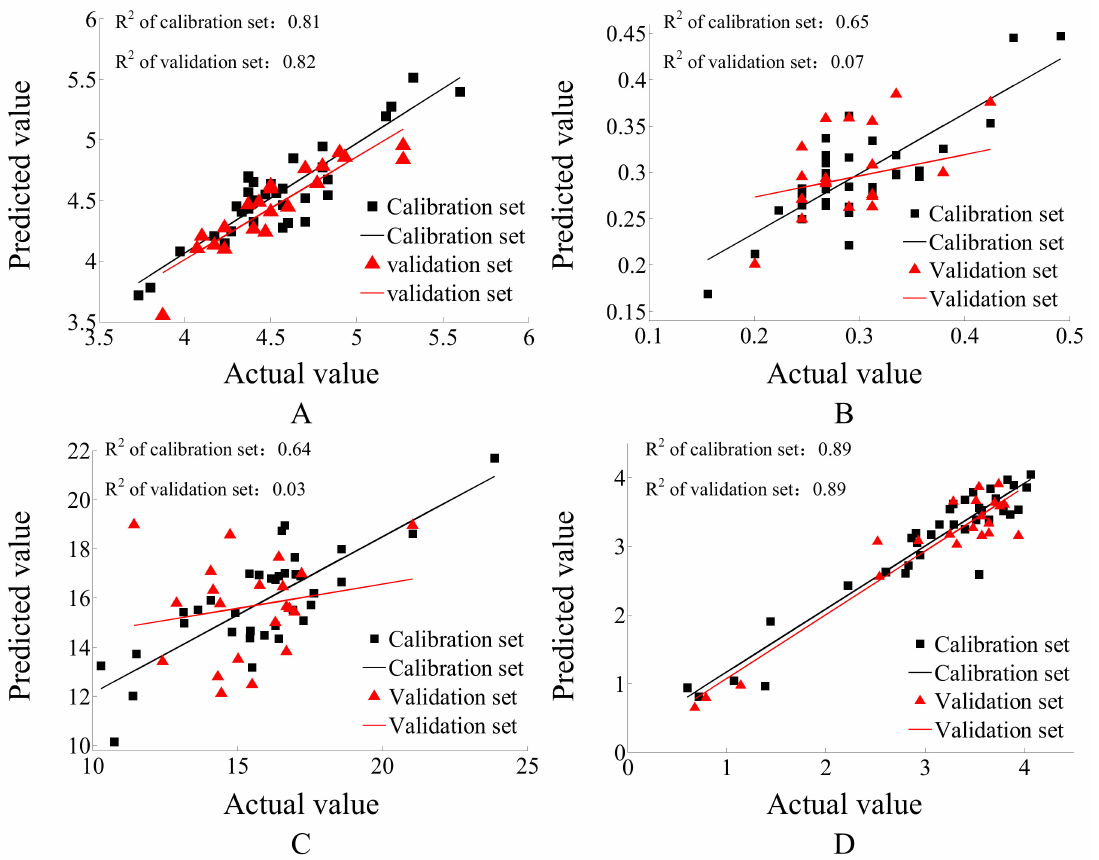
Figure 7. PLSR results of tomato physicochemical index prediction based on E-nose